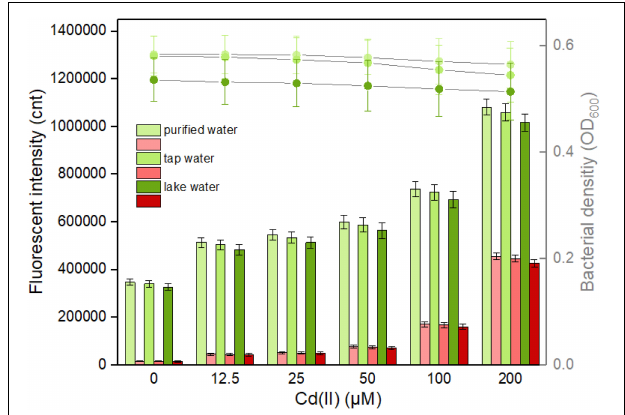
FIGURE 9 | Responses of the dual-sensing biosensor cell toward environmental water samples spiked with different concentrations of Cd(II). Luria-Bertani (LB)-incubated lag-phase cultures of the dual-sensing biosensor TOP10/pCadC-G-CadR-R were exposed to varying concentrations of Cd(II) in the following water samples: purified water, tap water, and lake water. After a 12-h incubation at 37 ◦ C, bacterial cell density was measured (point line diagram, right-Y scale), and both eGFP (green bars) and mCherry (red bars) fluorescence were determined (bar chart, left-Y scale). The fluorescent signal was indicated as a fluorescence count value (unit = cnt), and fluorescence intensity values were normalized using the absorbance at 600 nm. The green fluorescent intensity values of TOP10/pCadC-G-CadR-R were obtained by subtracting that of TOP10/pCadC, and the red fluorescent intensity values of TOP10/pCadC-G-CadR-R were obtained by subtracting that of TOP10/pCadR. Results are the average of at least three independent experiments performed in